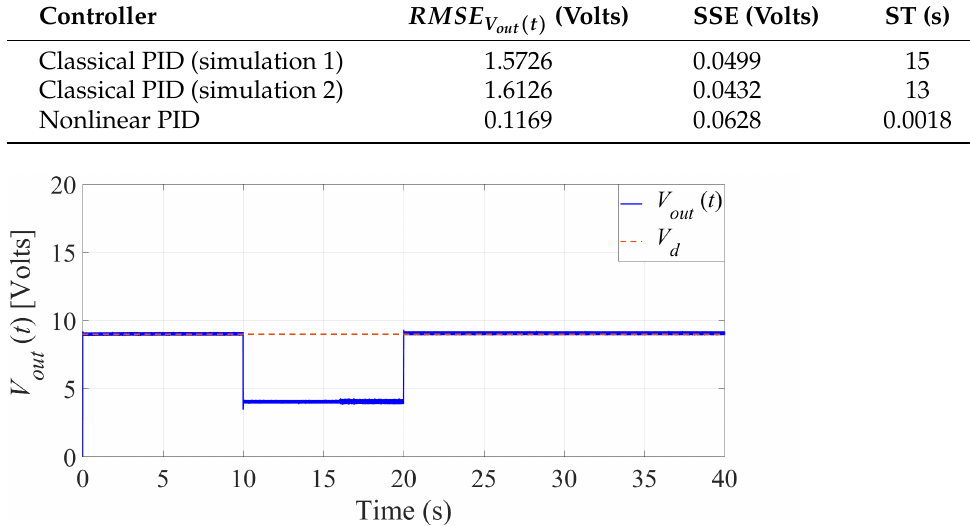
Figure 16. Scenario 2: Output voltage ( V out ( t ) ) implementing the proposed nonlinear PID